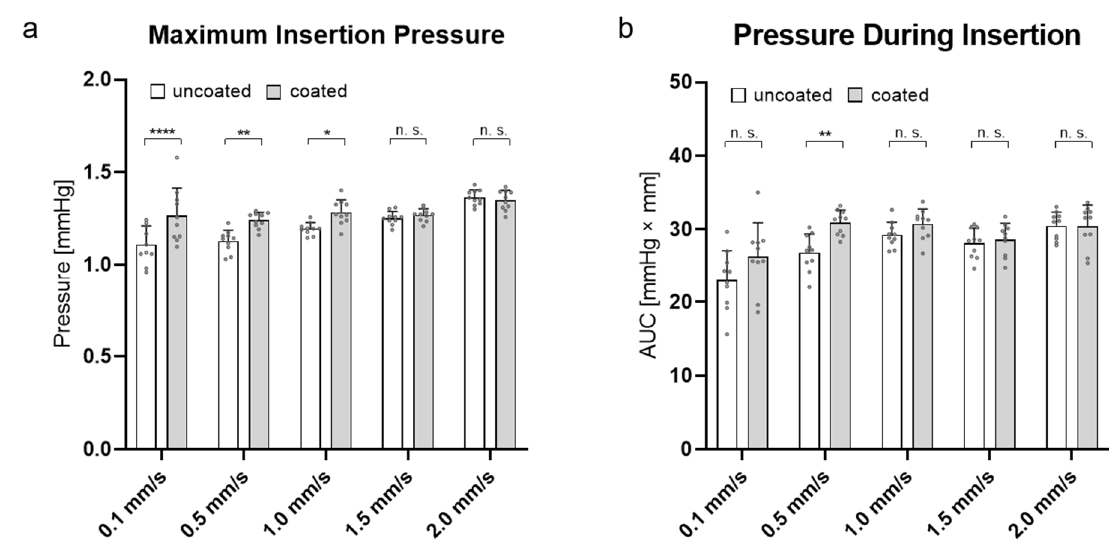
Figure 4. ( a ) Maximum insertion pressure of uncoated and coated electrode arrays at 5 different insertion speeds (0.1, 0.5, 1.0, 1.5, and 2.0 mm/s). ( b ) Insertion pressure during insertion (area under the curve (AUC)) of uncoated and coated electrode arrays at five different insertion speeds. n = 10 independent repetitions were performed for each insertion speed. Data are presented as mean with positive standard deviation (lines). Dots represent independent measured values. p -values were calculated by two-way ANOVA followed by Sidak’s multiple comparison post hoc test. * p < 0.05. ** p < 0.01. **** p < 0.0001. n. s. = not significant.